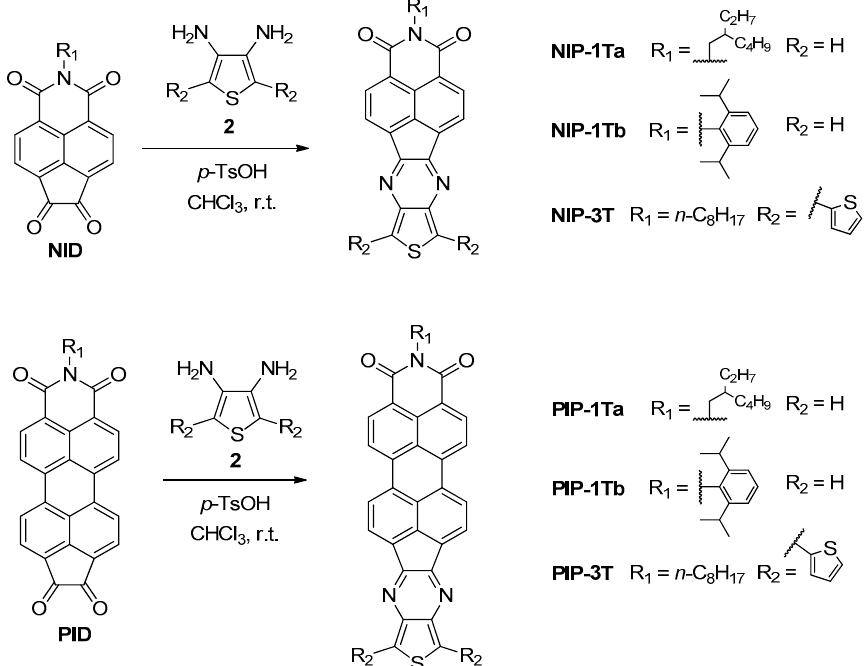
Figure 12. General structure of the fifth generation of oligothiophene–naphthalimide assemblies. Pyrazine-based materials can be obtained by condensation reactions between naph- thalene ( NID ) or peryleneimides ( PID ) endowed with 1,2-diketone functionalities and the corresponding diaminothiophene derivatives (Scheme 6)